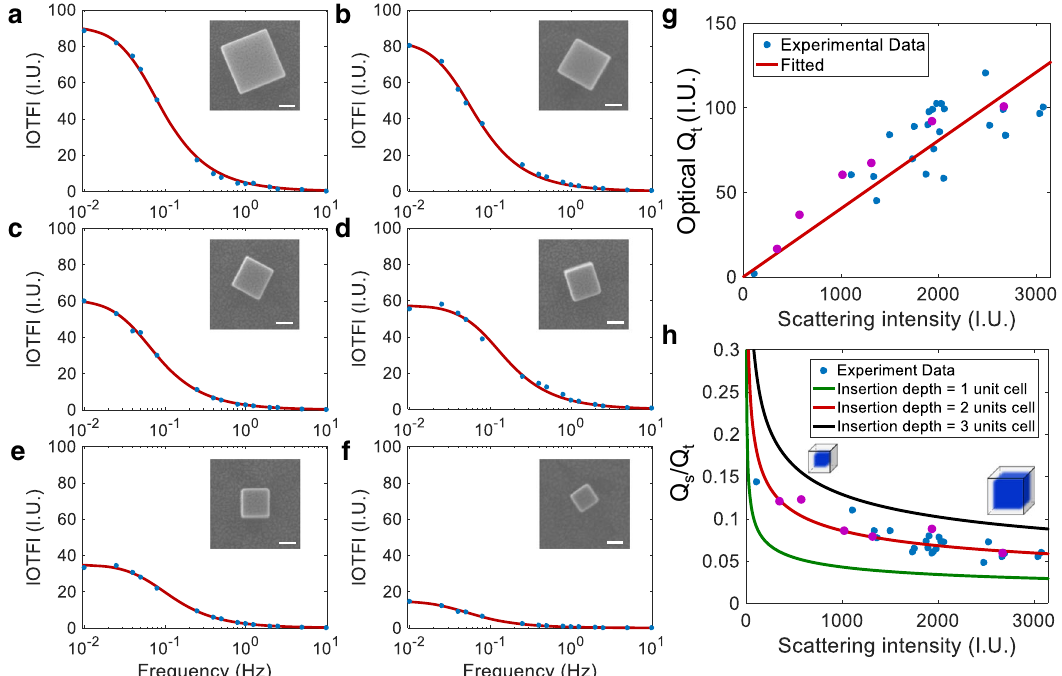
Fig. 3 The oEIS of different single PBNPs individual and the corresponding statistical results. a – f The oEIS of six representative single PBNPs. The red line shows the fi tted results, and the blue dots are experimental data. The top right corner is the corresponding SEM image. Scale bar: 100 nm. g Dependence of optical Q t and ( h ) Q s /Q t with the scattering intensity of single PBNPs by analyzing 30 individual species. Each dot represents an individual particle, and the dots corresponding to the six representative particles shown in ( a – f ) are marked in purple. The green, red, and black curves represent the theoretical Q s /Q t curves as a function of the nanoparticle size by assuming a shell-layer depth of 1, 2, and 3 unit cells, respectively. Source data are provided as a Source Data fi